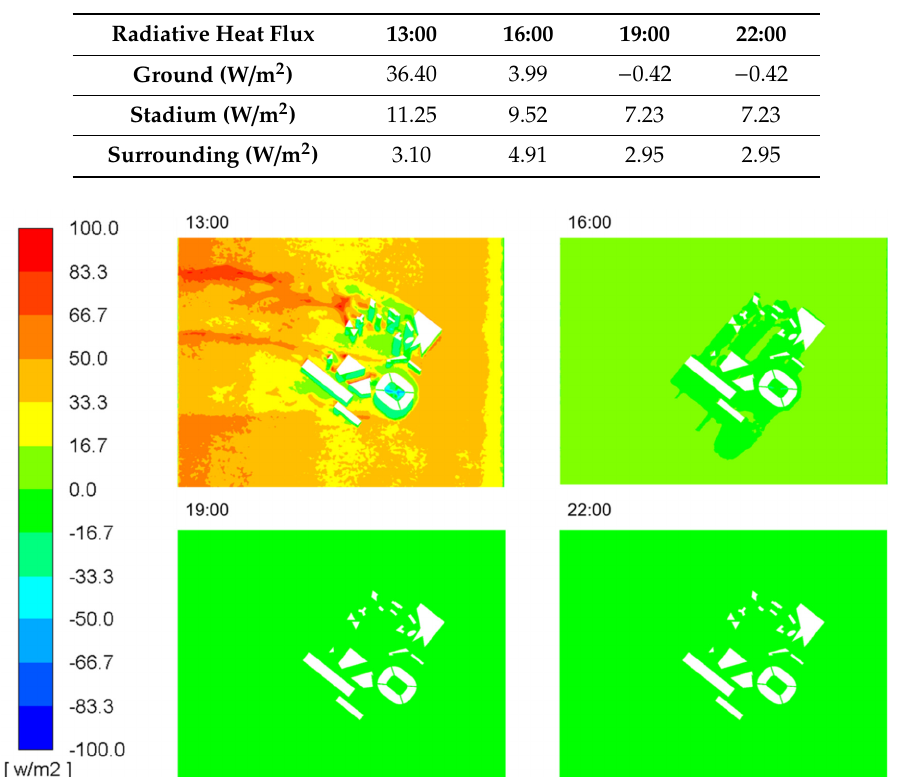
Figure 9. It is obviously observed that the radiative heat fluxes from the ground at 13:00 is the most intensive among those for the four kick-o ff times. Hence, the results obtained from the solar radiation simulation under 13:00 are used as the thermal boundary conditions for the further assessments of each cooling configuration and a baseline configuration. Table 5. Radiative heat fluxes for ground, stadium and surroundings for each kick-o ff time on 21 November.